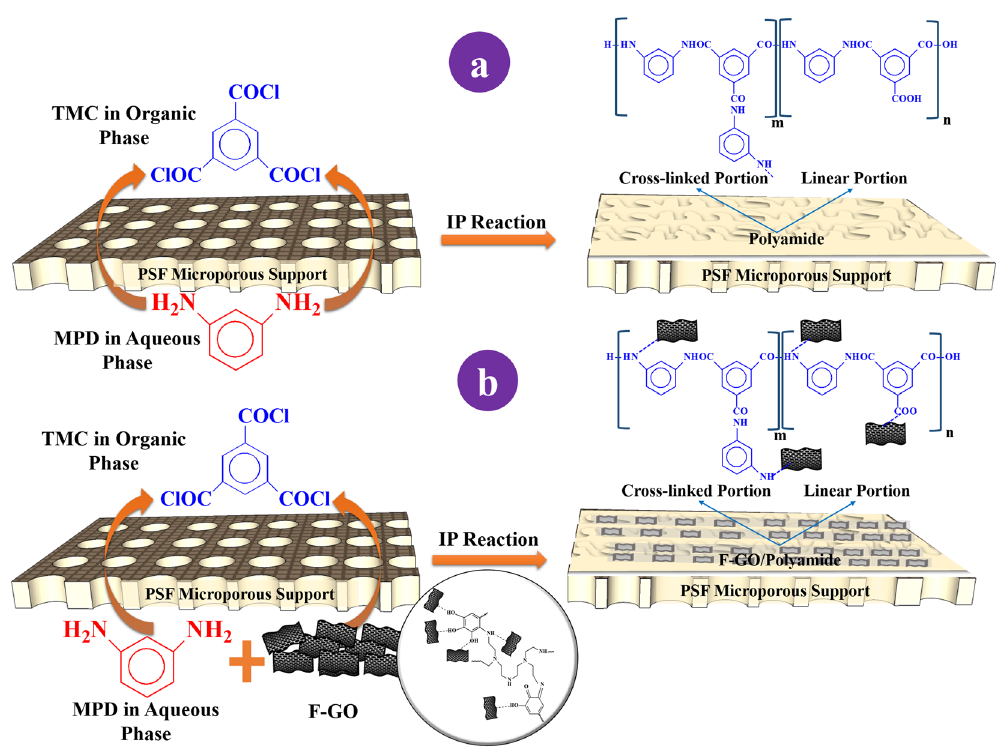
Figure 3. ( a ) Schematic depiction of IP reaction among MPD aqueous phase and TMC organic phase on the top of PSF microporous support and the chemical formulation of pristine PA layer, where m and n denotes the crosslinked and the linear portions of PA layer. ( b ) The chemical reaction and formulation of pTA-f-GO nanosheets embedded into the PA layer within MPD aqueous